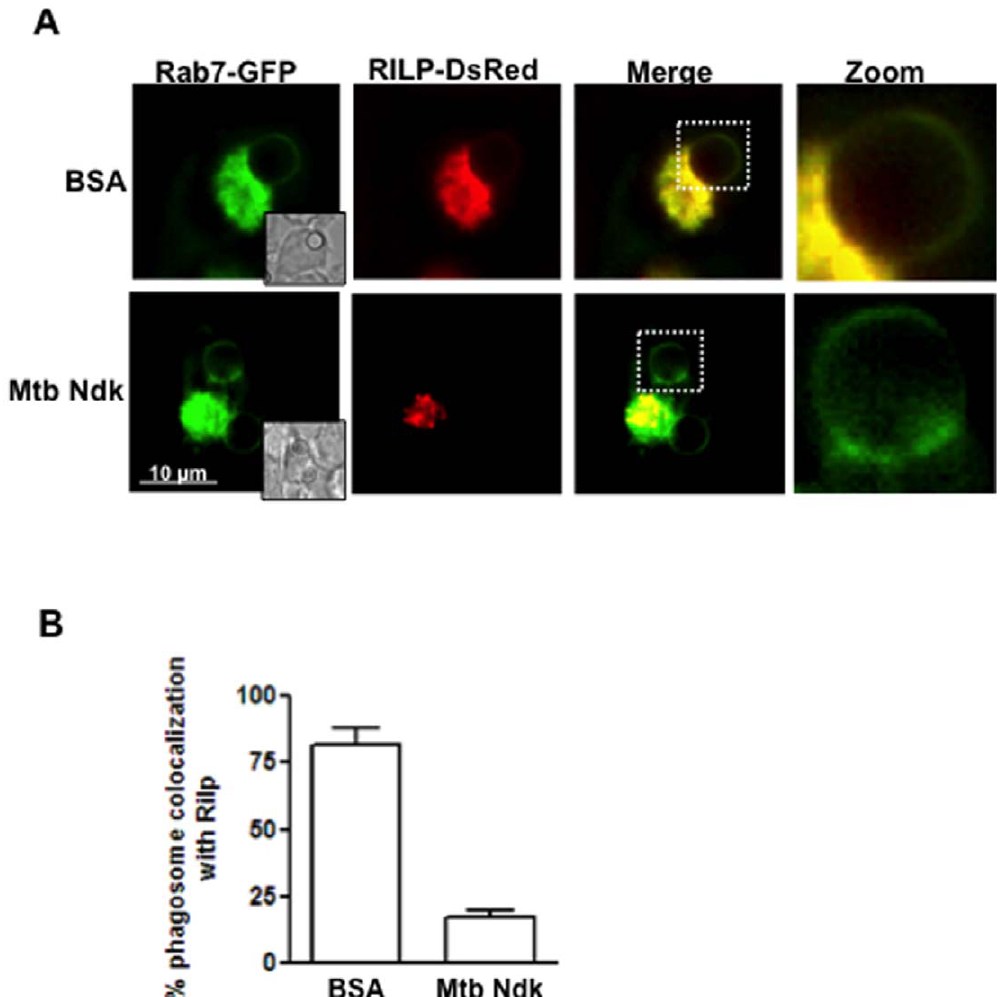
Figure 4. A. Ndk disrupt Rab7-RILP interaction. RAW cells were double transfected with Rab7-GFP and RILP-DsRed as described in Materials and Methods. Thereafter, cells were allowed to ingest either control BSA- or Ndk-coated latex beads. The yellow signal seen (upper panel) shows colocalization of Rab7 and RILP on the phagosome. The green signal (lower panel) shows phagosomes positive for Rab7 but no recruitment of RILP. B. Quantification of the confocal data shown in panel A. Values in B are the mean 6 SD of phagosome colocalization with RILP-DsRed in 50–80 cells from three independent experiments.